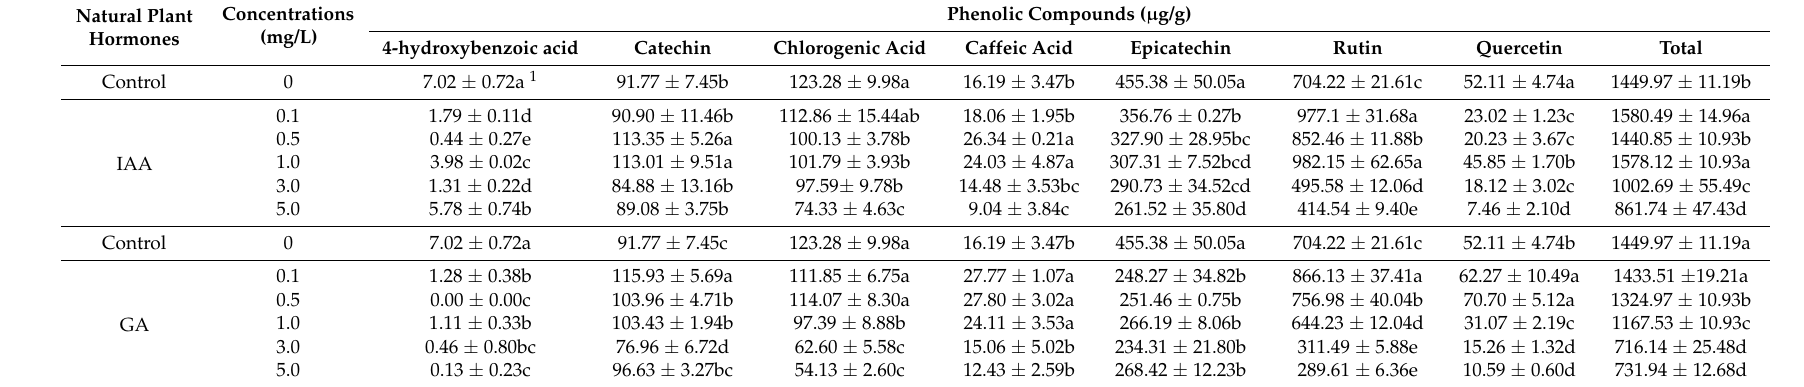
1 Means with different letters (a, b, c, d, and e) in the same column differ significantly ( p < 0.05, ANOVA,